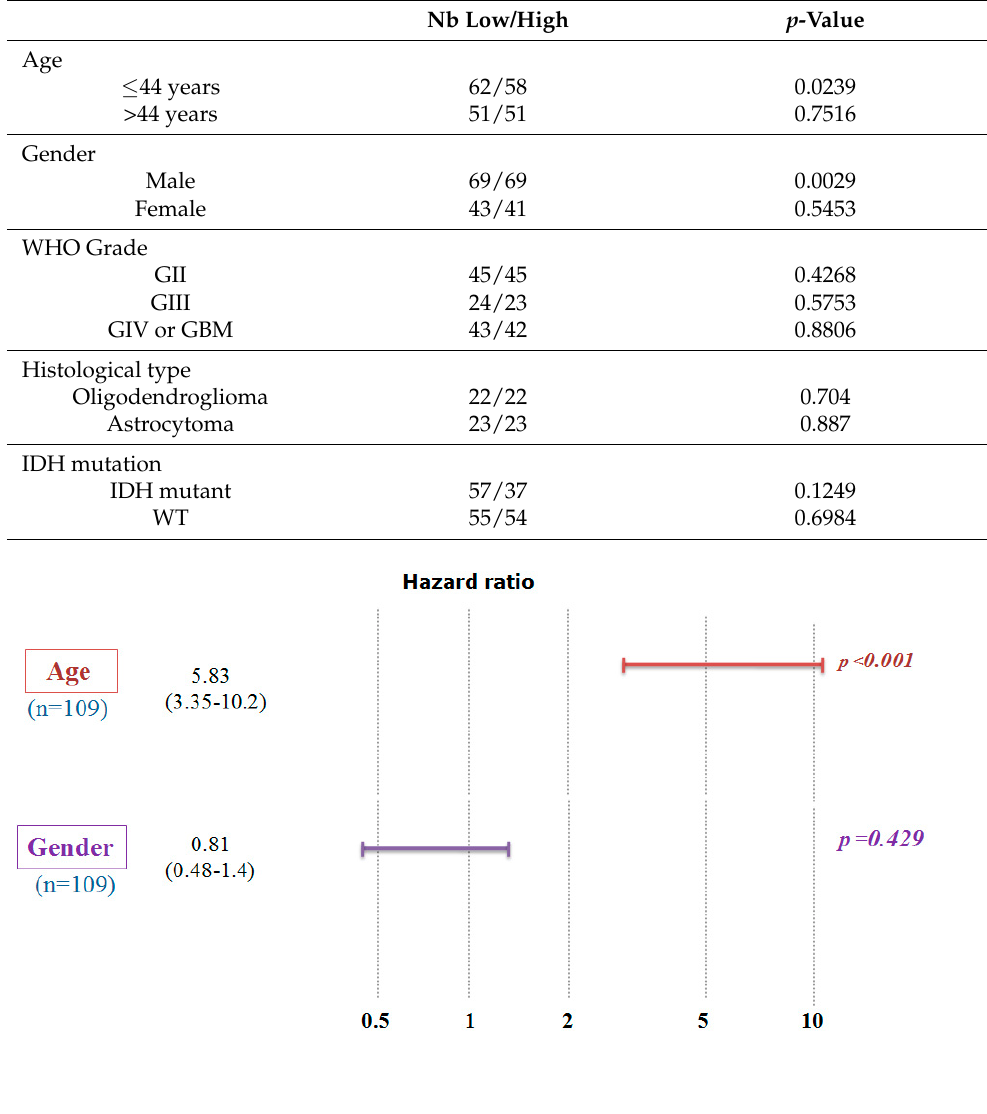
Table 3. Impact of A 2A R gene expression level on poor prognosis of CGGA patients with sub-median age or males.